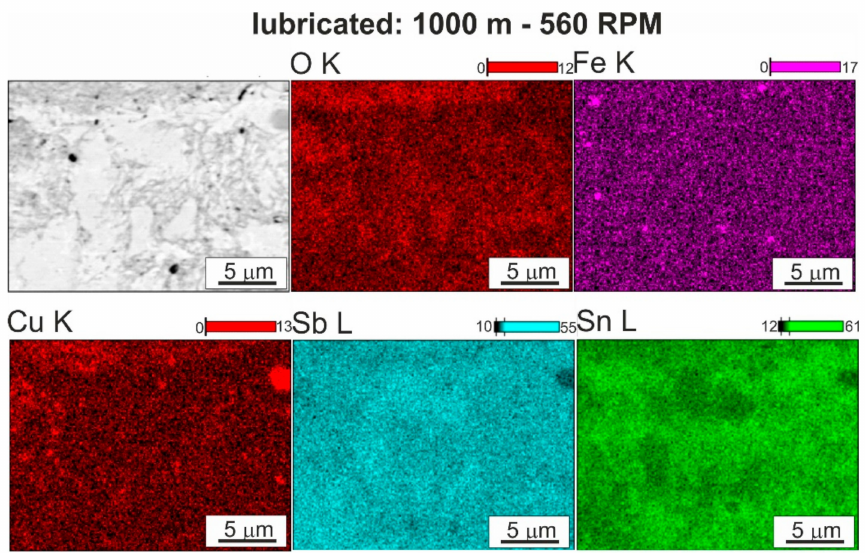
Figure 12. Surface after friction of SnSb11Cu6 alloy FSP modified using speed of 560 RPM and maps of distribution of elements: O, Fe, Cu, Sn, Sb; lubricated friction;